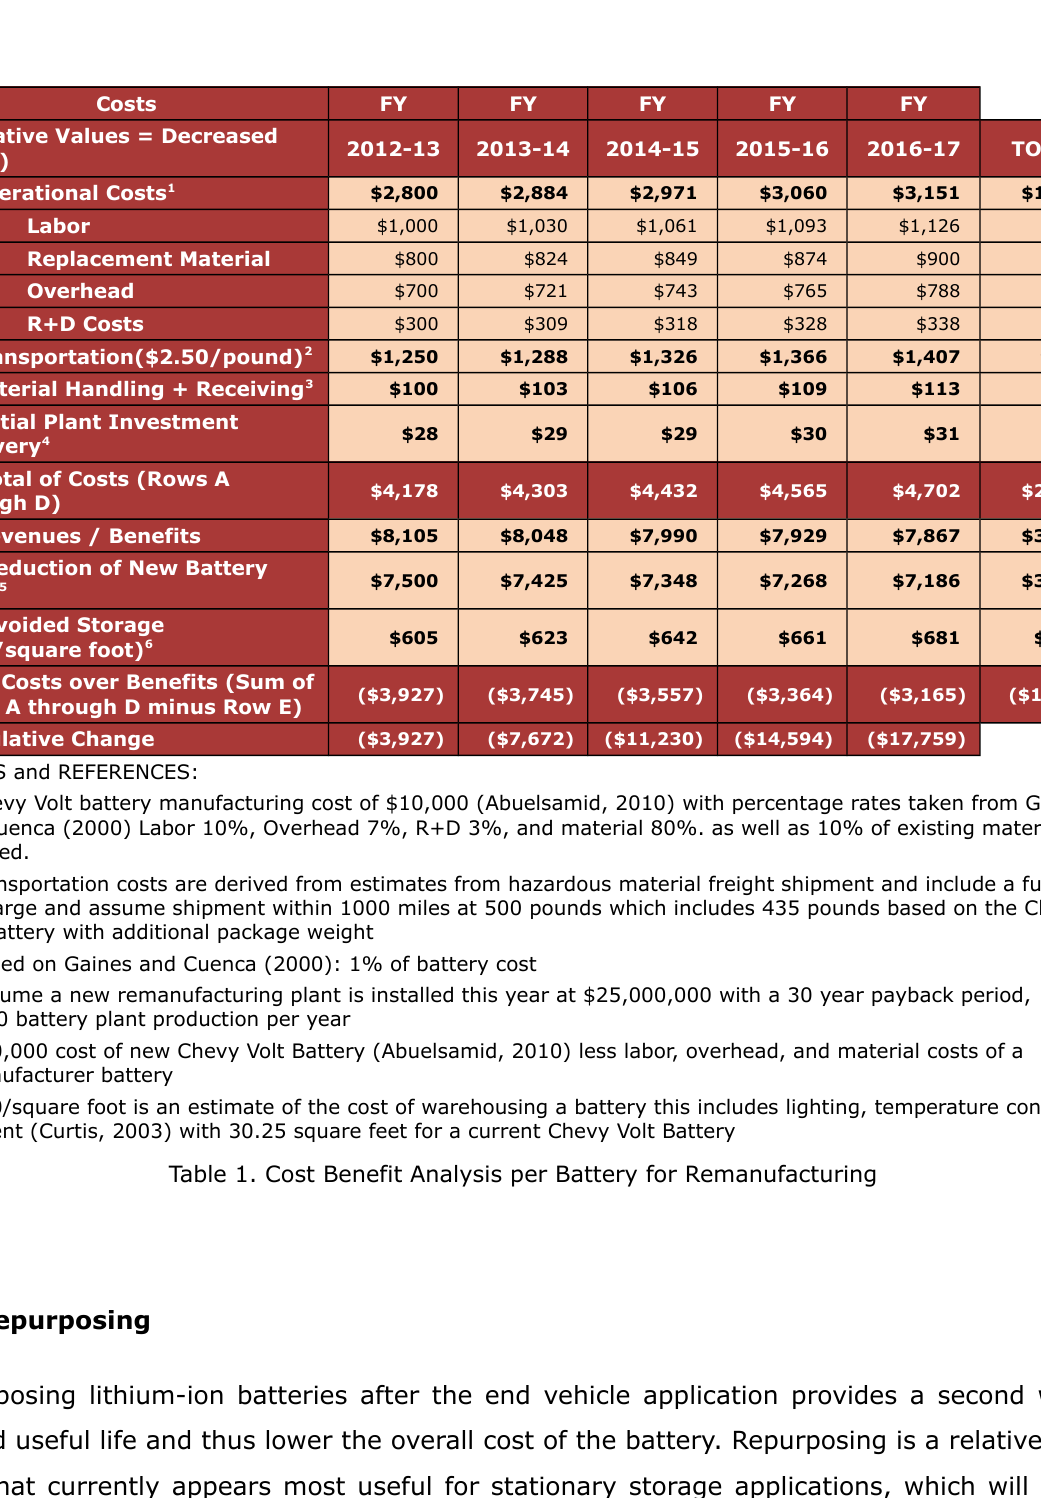
Table 1. Cost Benefit Analysis per Battery for